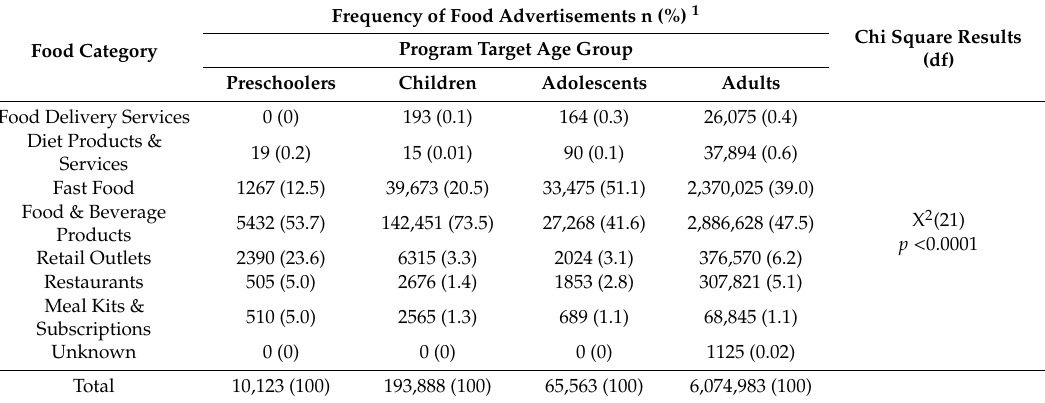
Table 4. Age-specific frequency and proportion of food advertising, by food category, on Canadian Table